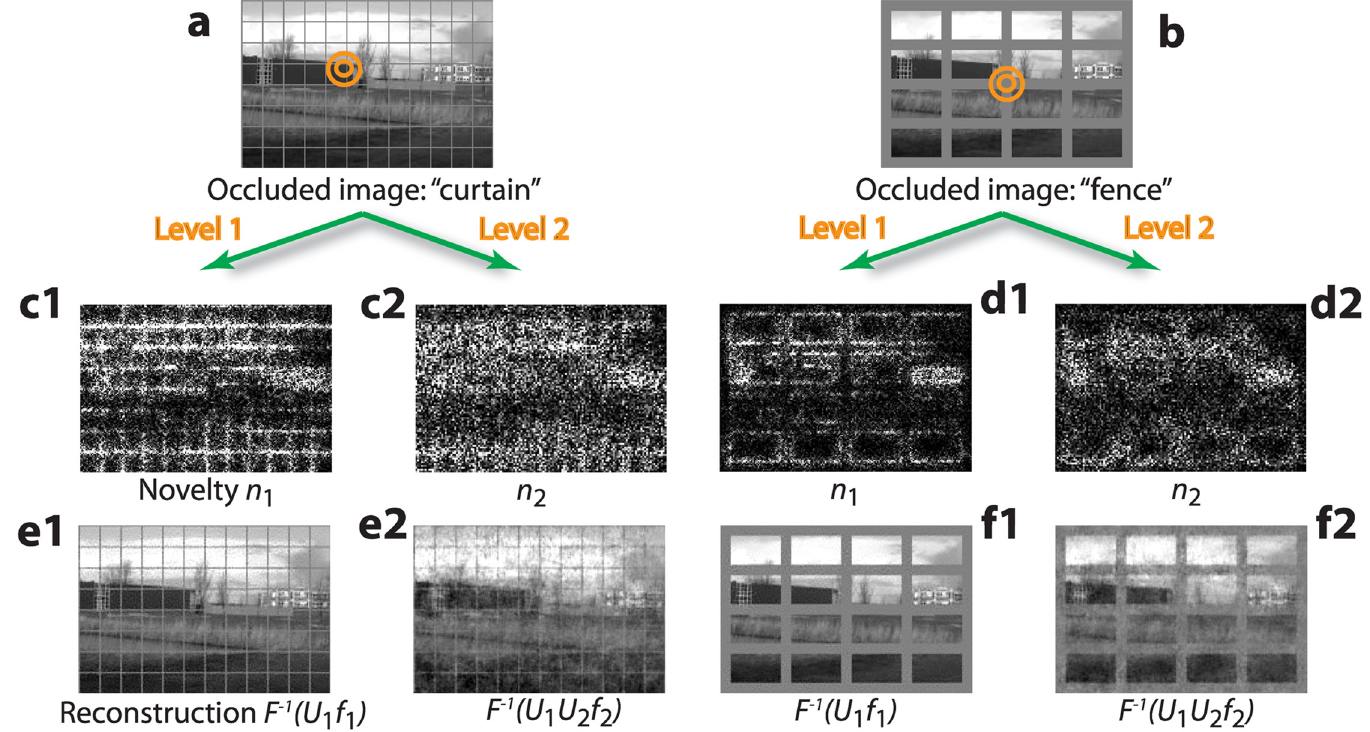
Fig 4. Novelty detection and familiarity information fill-in at different spatial scales. A familiar image is either occluded by a narrow, 1-pixel-wide ‘ curtain ’ ( a ) or by a 7-pixel-wide ‘ fence ’ ( b ). Circles represent the RFs of level-1 (smaller circle) and level-2 neurons, respectively. Novelty neurons at level 1 are activated by the fine curtain ( c1 ), while at level 2, curtain information is filtered out ( c2 ). For the fence, novelty at level 1 is only detected at some edges ( d1 ), but novelty of the wide fence bars is detected at level 2 ( d2 ). Reconstruction of the image (LGN activity) based on the level-1 and level-2 familiarity neurons for the curtain ( e1, 2 ) and the fence occlusions ( f1, 2 ) shows how the occluded parts of the image are filled in despite the reduced number of